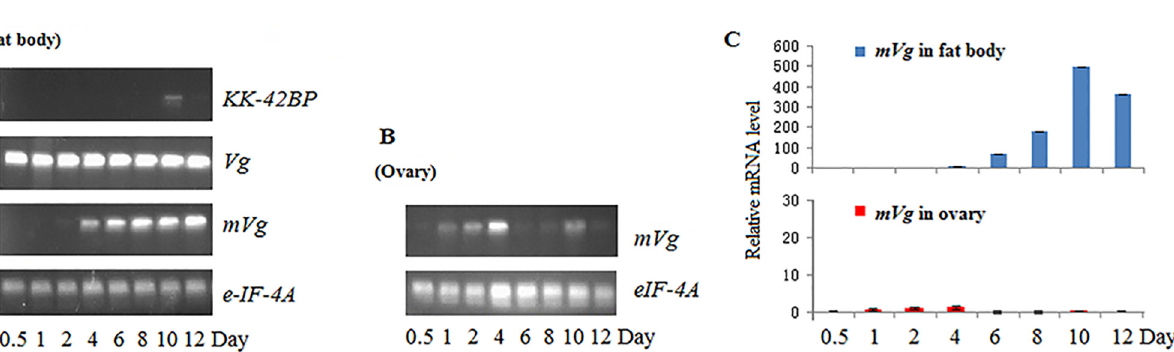
Fig 4. Comparative expression patterns of the mVg gene. (A) Expression patterns in the fat body among the mVg , Vg , and KK-42BP genes investigated by RT-PCR with the eIF-4A gene used as the control. (B) Expression of mVg in the ovary. (C) Relative mRNA expression level of the mVg gene in the fat body and ovary detected by qRT-PCR.